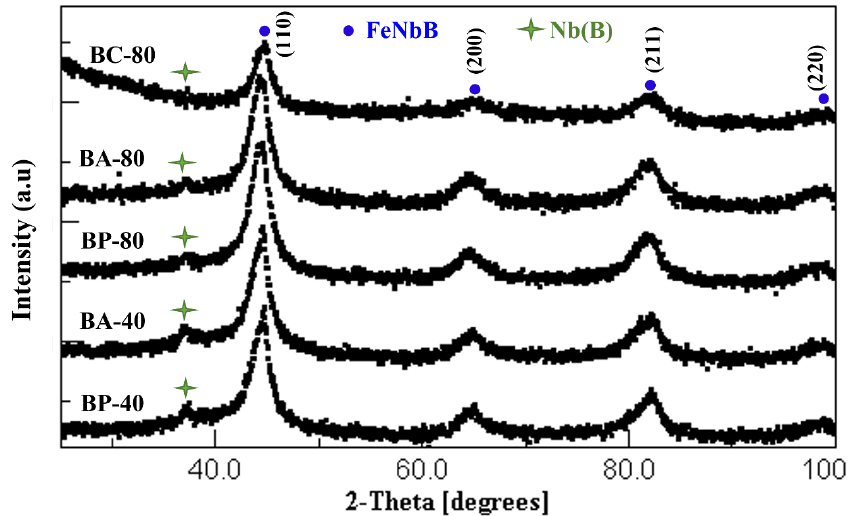
Figure 4. XRD diffractograms for samples of B alloy (Fe 80 Nb 8 B 12 ).